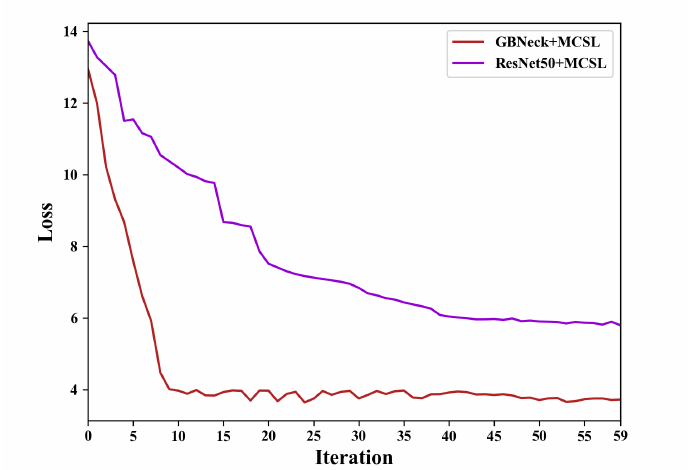
Figure 4. The mean training loss curves from 5 runs of MCSL with the backbone ResNet50 and GBNeck on the Market-1501 dataset. The horizontal and vertical coordinates represent the iteration number and the loss value,